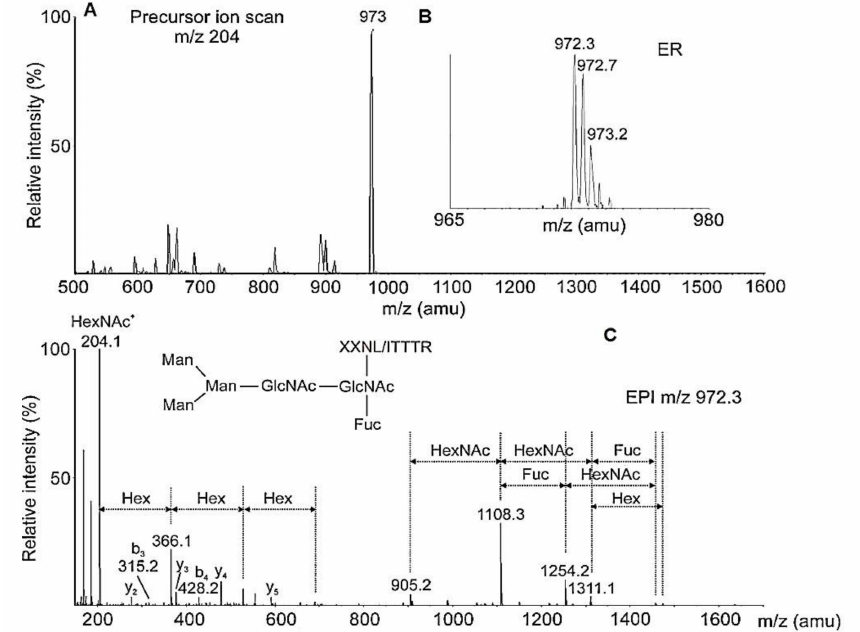
Figure 17. ( A ) Ion scanning of 23-min eluted fraction. ( B ) ER scanning of the intensive ion; ( C ) CEPI scanning of fragmenting ions. Increase of the mass of ion b3 with 1 Da in EPI spectra is compared to the MS / MS of the labeled peptides